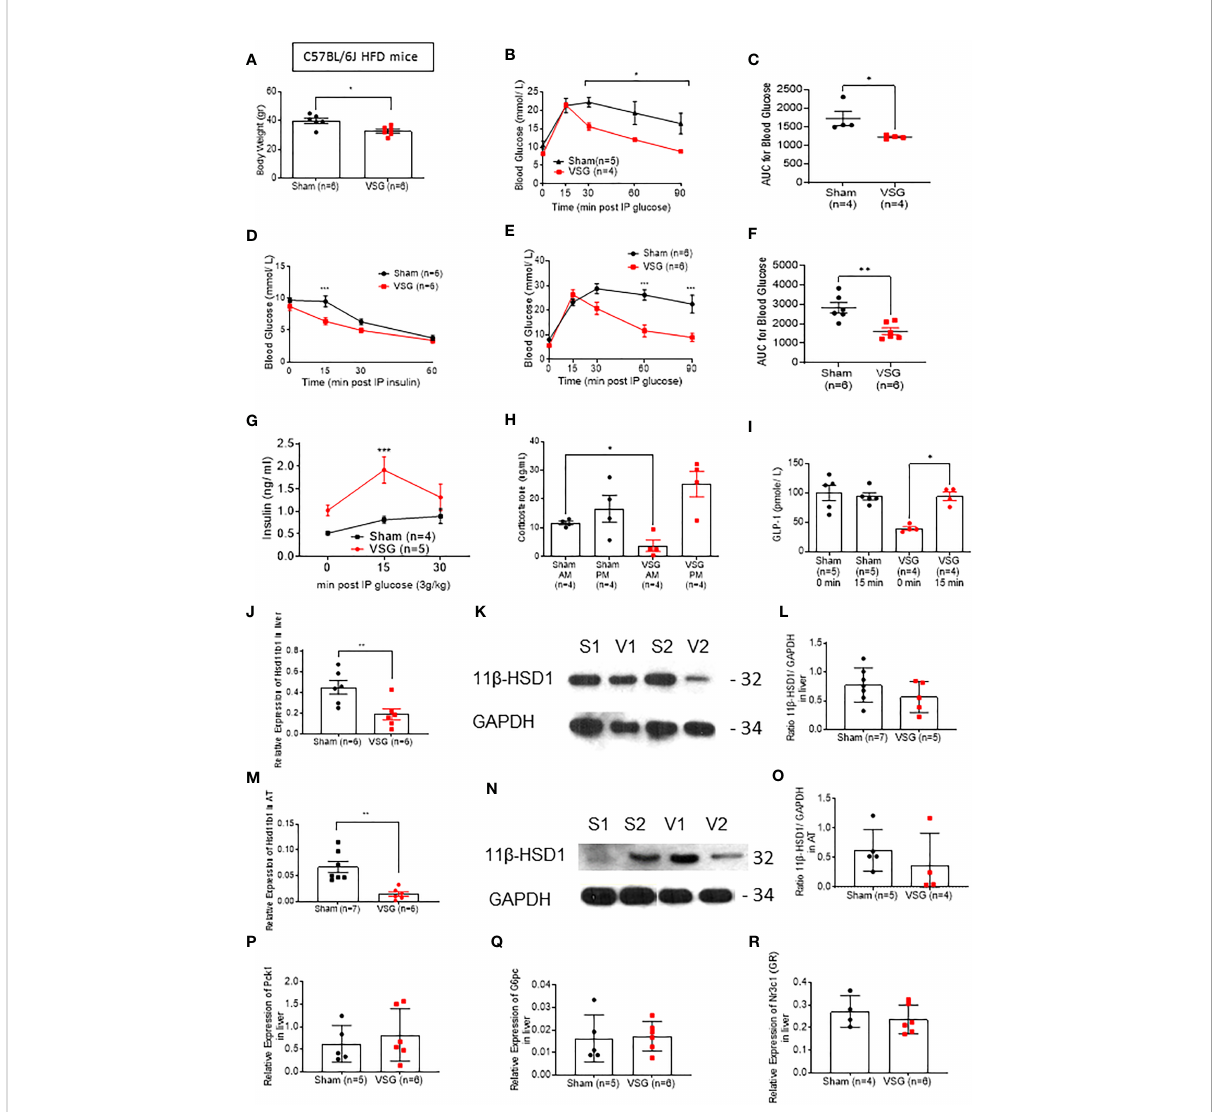
FIGURE 2 VSG restores physiological corticosterone production in HFD mice (A) Body weight at ten weeks following VSG (n = 6) or sham surgery (n = 6) in HFD animals (B) IPGTT in HFD mice (1 g/kg) 8hr fasting ten weeks after surgery *P< 0.05 Sham vs. VSG following 2-way ANOVA (C) Area under the Curve of (B) . *P < 0.05 Sham vs. VSG by two-sided unpaired Student ’ s t – test (D) Insulin tolerance test in HFD mice (1.5 IU/kg) 6hr fasting, ten weeks after surgery ***P < 0.001 Sham vs. VSG following 2-way ANOVA (E) IPGTT in HFD mice (3 g/kg) overnight fasting ten weeks after surgery ***P < 0.01 Sham vs. VSG following 2-way ANOVA (F) Area under the Curve of (B) . **P < 0.001 Sham vs. VSG by two-sided unpaired Student ’ s t – test (G) Insulin secretion following IPGTT (3 g/kg) and overnight fasting (H) Corticosterone measurement following blood collection at 0800 and 1900 within the same day, ten weeks after surgery *P < 0.05 Sham vs. VSG by two-sided unpaired Student ’ s t – test. (I) GLP-1 secretion following 3g/kg oral glucose gavage after overnight fasting *P < 0.05 Sham vs. VSG by two-sided unpaired Student ’ s t – test (J) Quantitative PCR levels of Hsd11b1 gene expression in liver *P < 0.05 Sham vs. VSG by two-sided unpaired Student ’ s t – test **P < 0.01 Sham vs. VSG by two-sided unpaired Student ’ s t – test (K) Western Blot of liver lysate from sham and VSG mice for 11 b -HSD1 (32kDa) and GAPDH (34kDa) (L) Average intensity measurement from Western Blot immunoblotting quanti fi cation for 11 b -HSD1 and GAPDH in liver. (M) Quantitative PCR levels of Hsd11b1 gene expression in subcutaneous adipose tissue ***P < 0.001 Sham vs. VSG by two-sided unpaired Student ’ s t – test (N) Western Blot of adipose tissue lysate from sham and VSG mice for 11 b -HSD1 (32kDa) and GAPDH (34kDa) (O) Average intensity measurement from Western Blot immunoblotting quanti fi cation for 11 b -HSD1 and GAPDH in adipose tissue. (P) Quantitative PCR levels of Pck1 gene expression in liver (Q) Quantitative PCR levels of G6pc gene expression in liver (R) Quantitative PCR levels of Nr3c1 (GR) gene expression in liver. Data are expressed as means ±